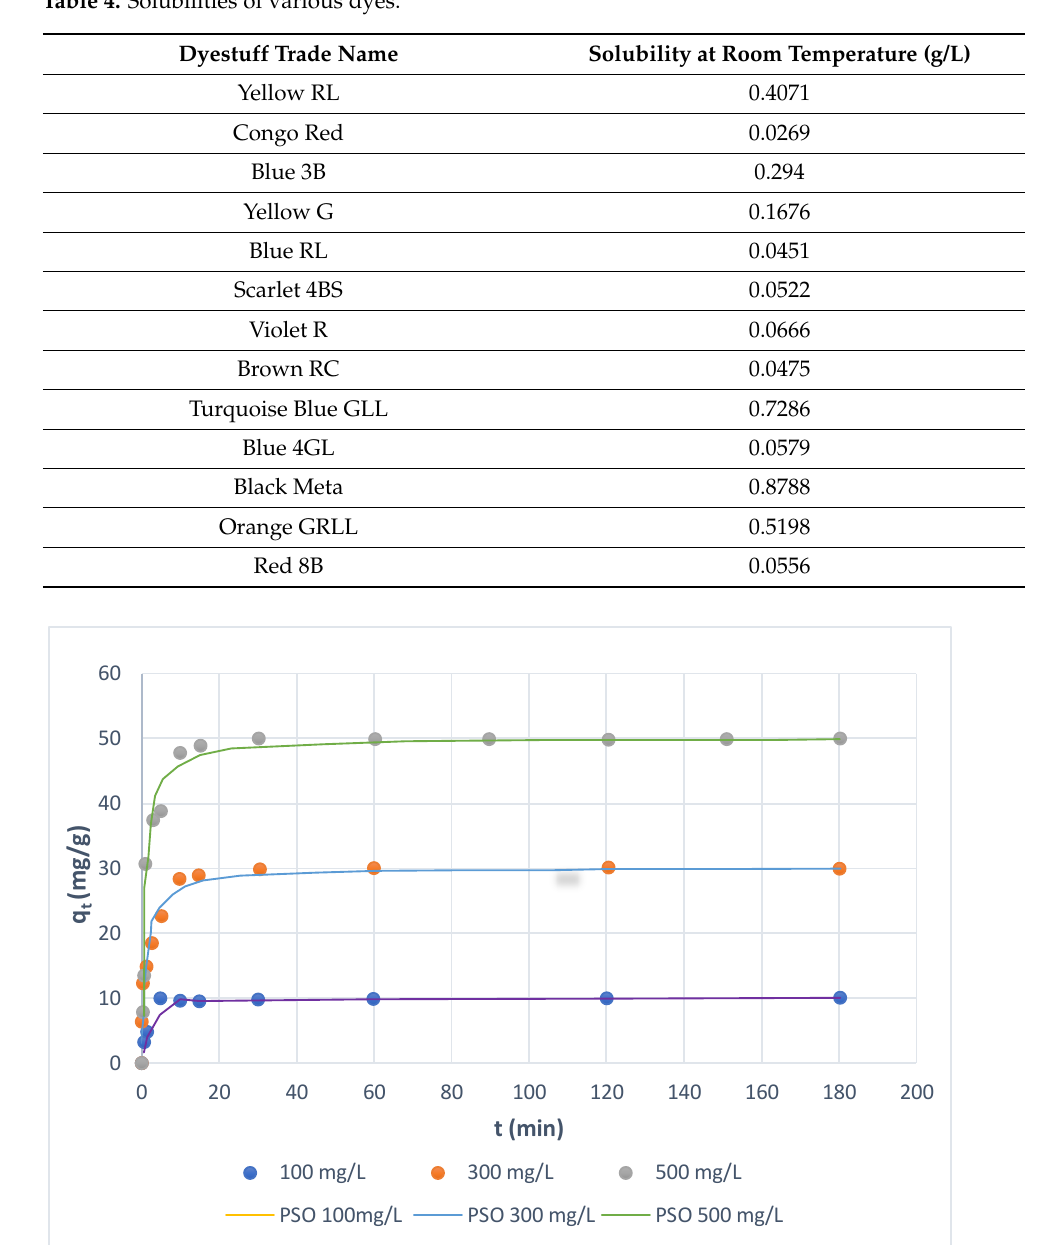
Table 4. Solubilities of various dyes.